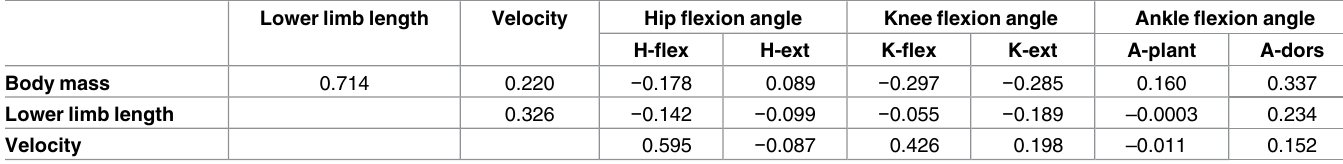
Table 6. Pearson product-moment correlation coefficients between body size parameters, velocity and flexion angles at selected gait events in a pooled sex sample (n =